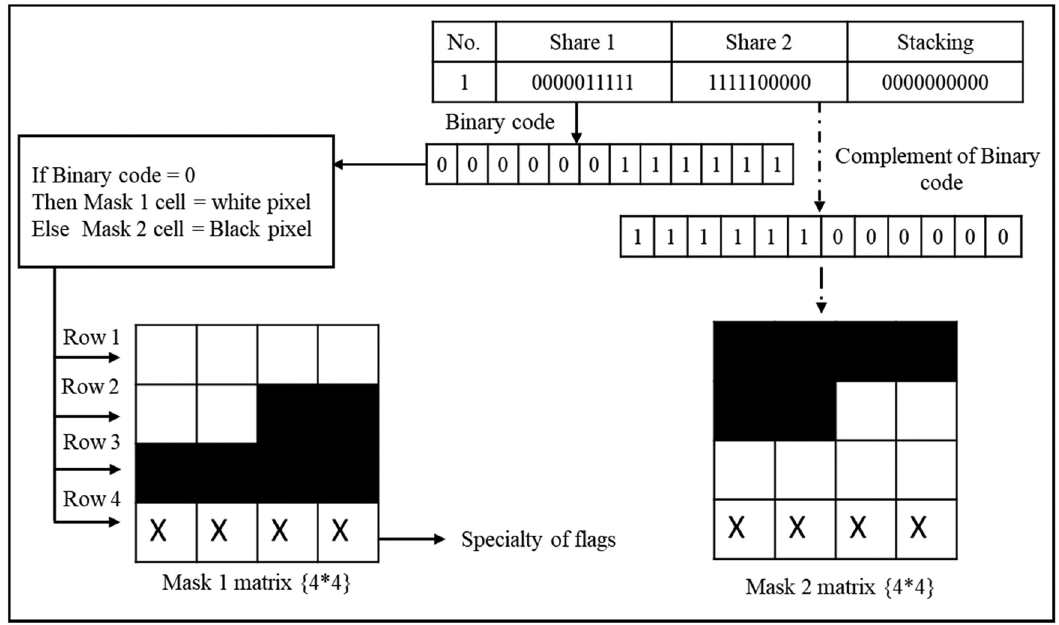
Figure 7: Create Mask 1 [ 4,4 ] and Mask 2 [ 4,4 ] matrix in Hash codebook where x represents default value for fl